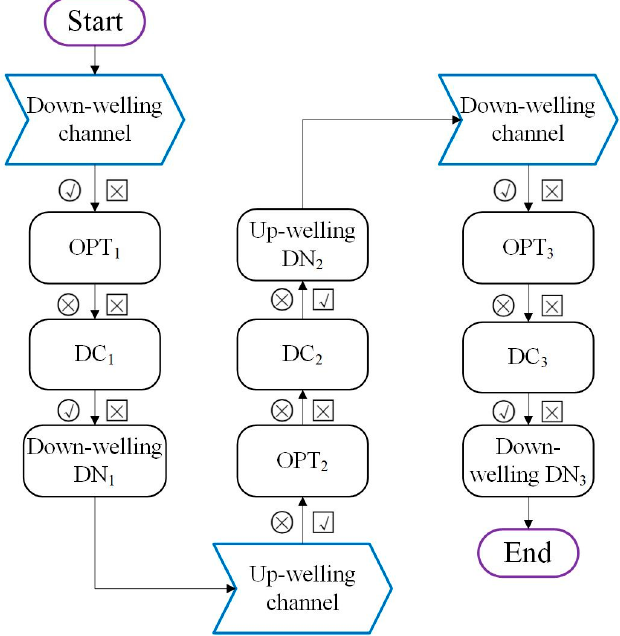
Figure 2. Flow diagram showing the data collection sequence used in the automated observation mode of the SIFSpec system. The circles and squares represent the downward and upward channels, respectively. The √ and × symbols indicate that the light channel is open and closed, respectively. ORT and DN indicate the optimization process of the integration time and the digital number measured by the spectrometer, respectively.